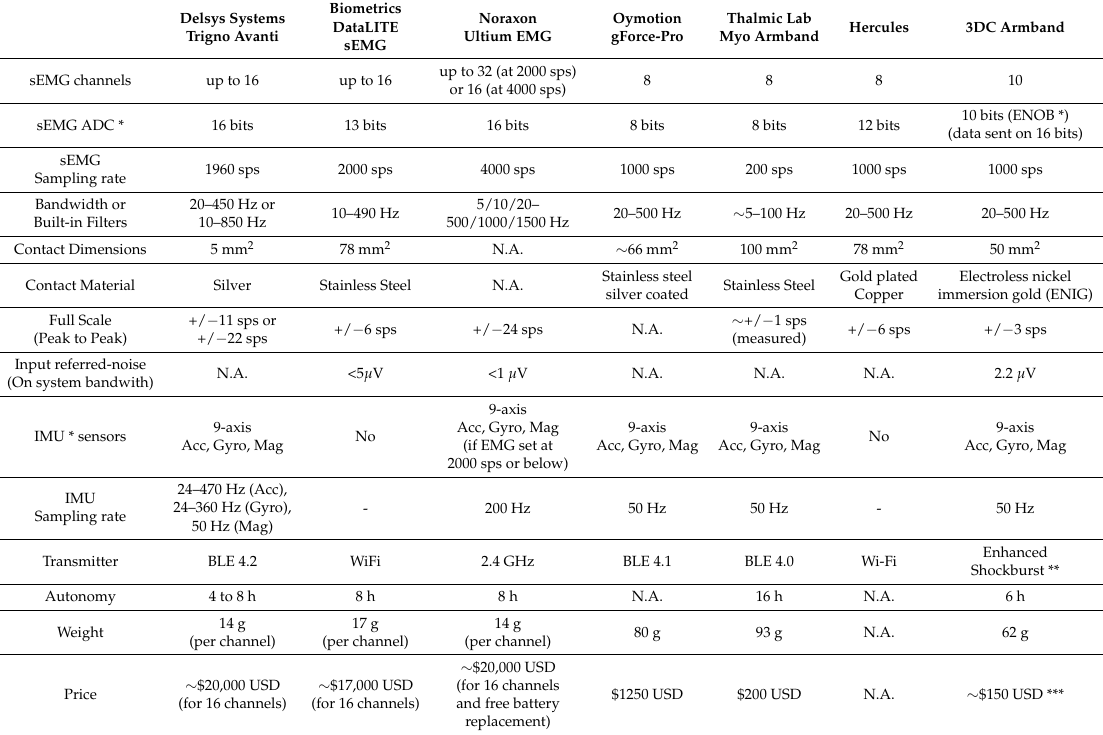
Table 1. Characterization of different surface electromyography (sEMG) acquisition systems. Values of N.A. mean that the information is not available. Note that, while the Hercules system [19] is included for completeness, it does not possess a wearable form